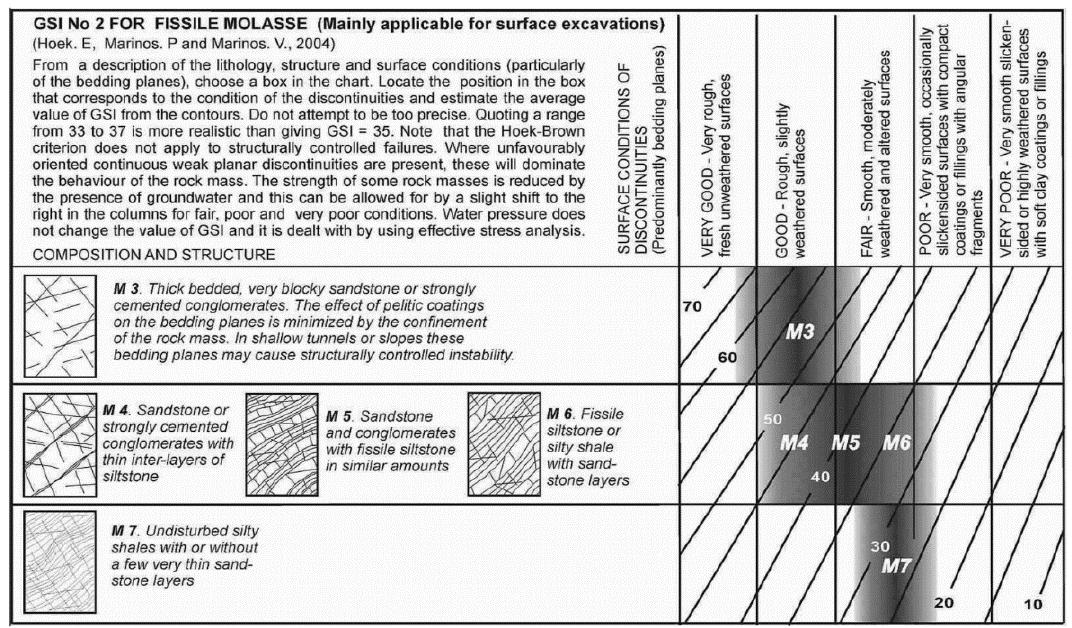
Figure A7. GSI chart for other rock masses [18].